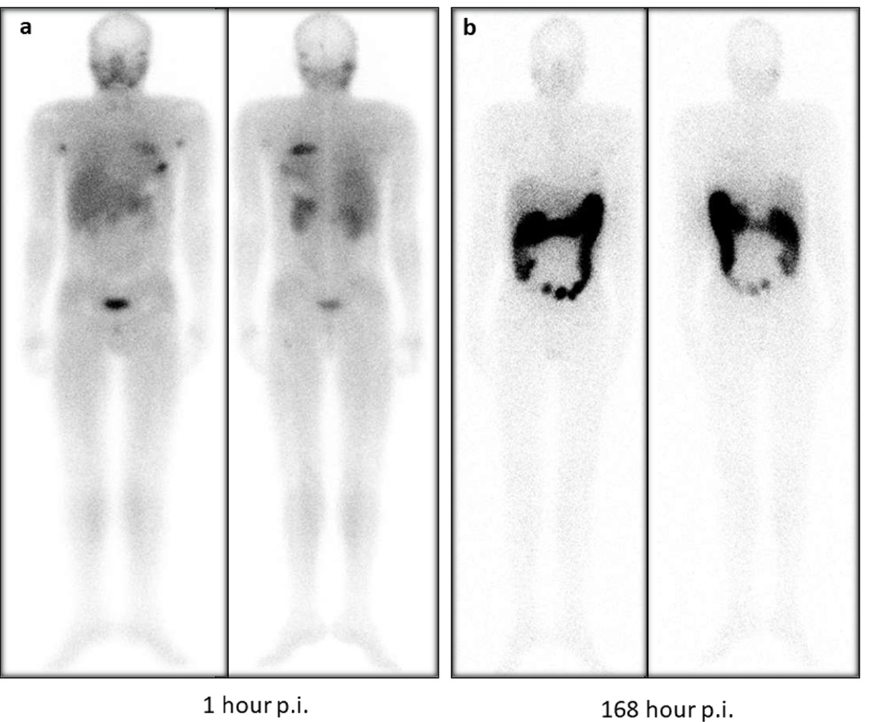
Figure 4. ( a ). A 27-year old male diagnosed with paraganglioma was treated with [ 177 Lu]Lu-DOTAGA.(SA.FAPi) 2 treat- ment, and the 1 h scan post-treatment showed ( a ) normal and minimal biodistribution of radiotracer in the oral mucosa, salivary glands, liver, pancreas, and kidneys. At 1 h p.i., intense accumulation of radiotracer was observed in the skull and rib lesions. The patient has a history of constipation and hence demonstrated persistent and intense uptake of [ 177 Lu]Lu- DOTAGA.(SA.FAPi) 2 radiotracer in the gut due to reduced intestinal motility, even at 168 h ( b ) post-treatment, reflecting higher radiation absorbed dose to the colon compared to the other patients, such the patient treated in Figure 3.